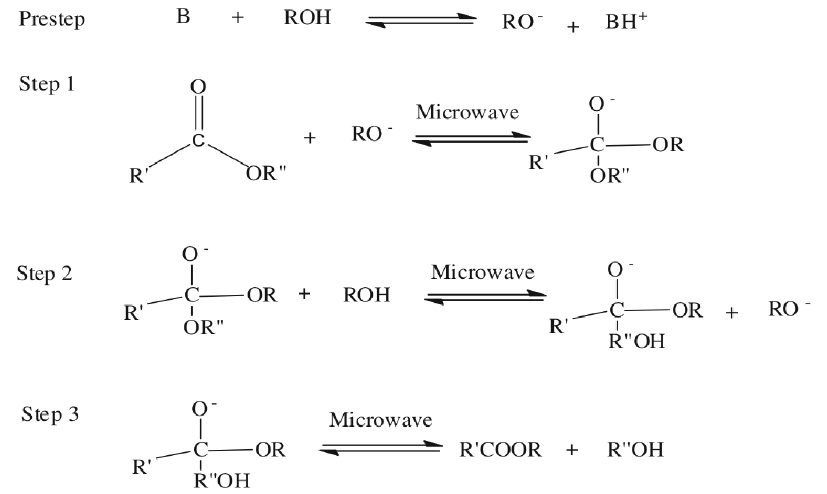
Figure 2. Mechanism of microwave transesterification reaction.